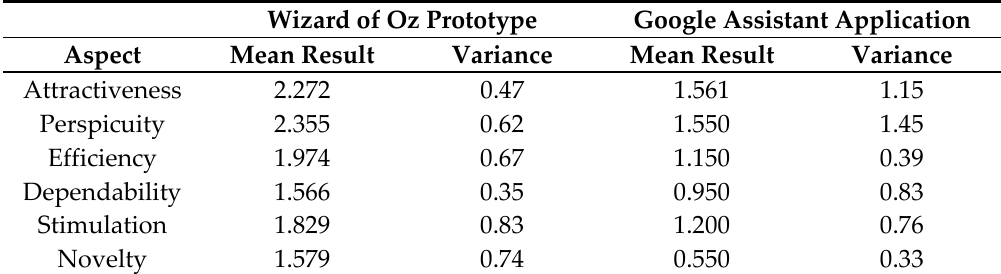
Table 1. UEQ scale results for both evaluations, Wizard of Oz and Google Assistant application. The mean value of the answers given by participants, and the variance of the results is given.